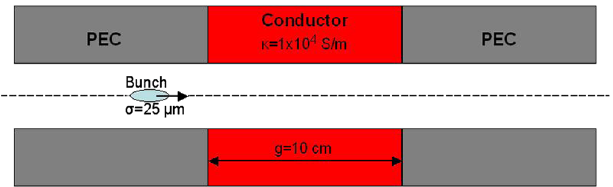
FIG. 11. Cross section of the finite-length resistive cylinder between infinitely long perfectly conducting